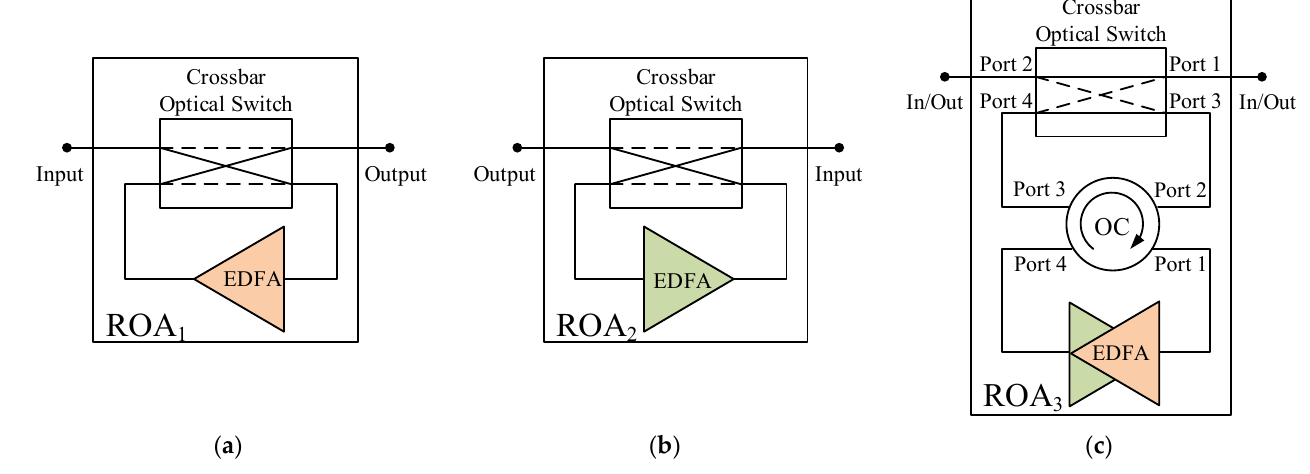
Figure 2. Block diagrams of ROAs: ( a ) ROA 1 ; ( b ) ROA 2 ; ( c ) ROA 3 .